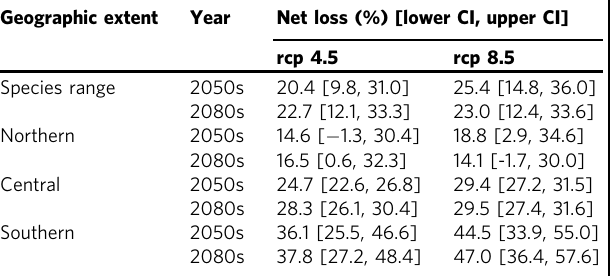
Phenology richness patterns from stacked distribution models .